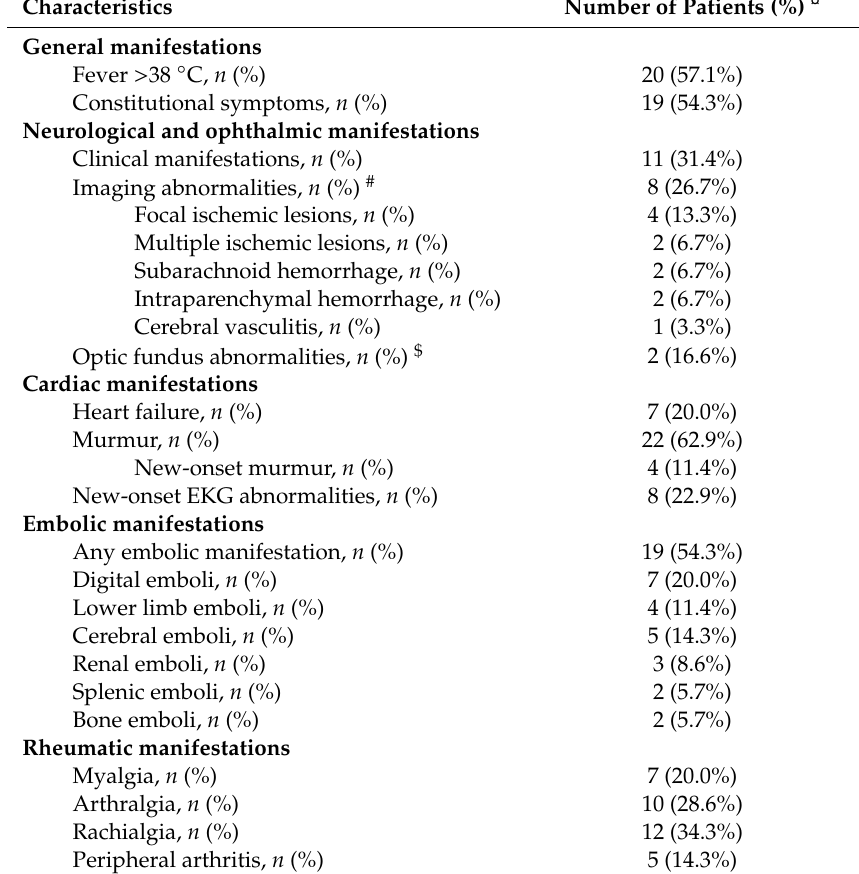
Table 2. Clinical, biological and imaging characteristics at infective endocarditis (IE)